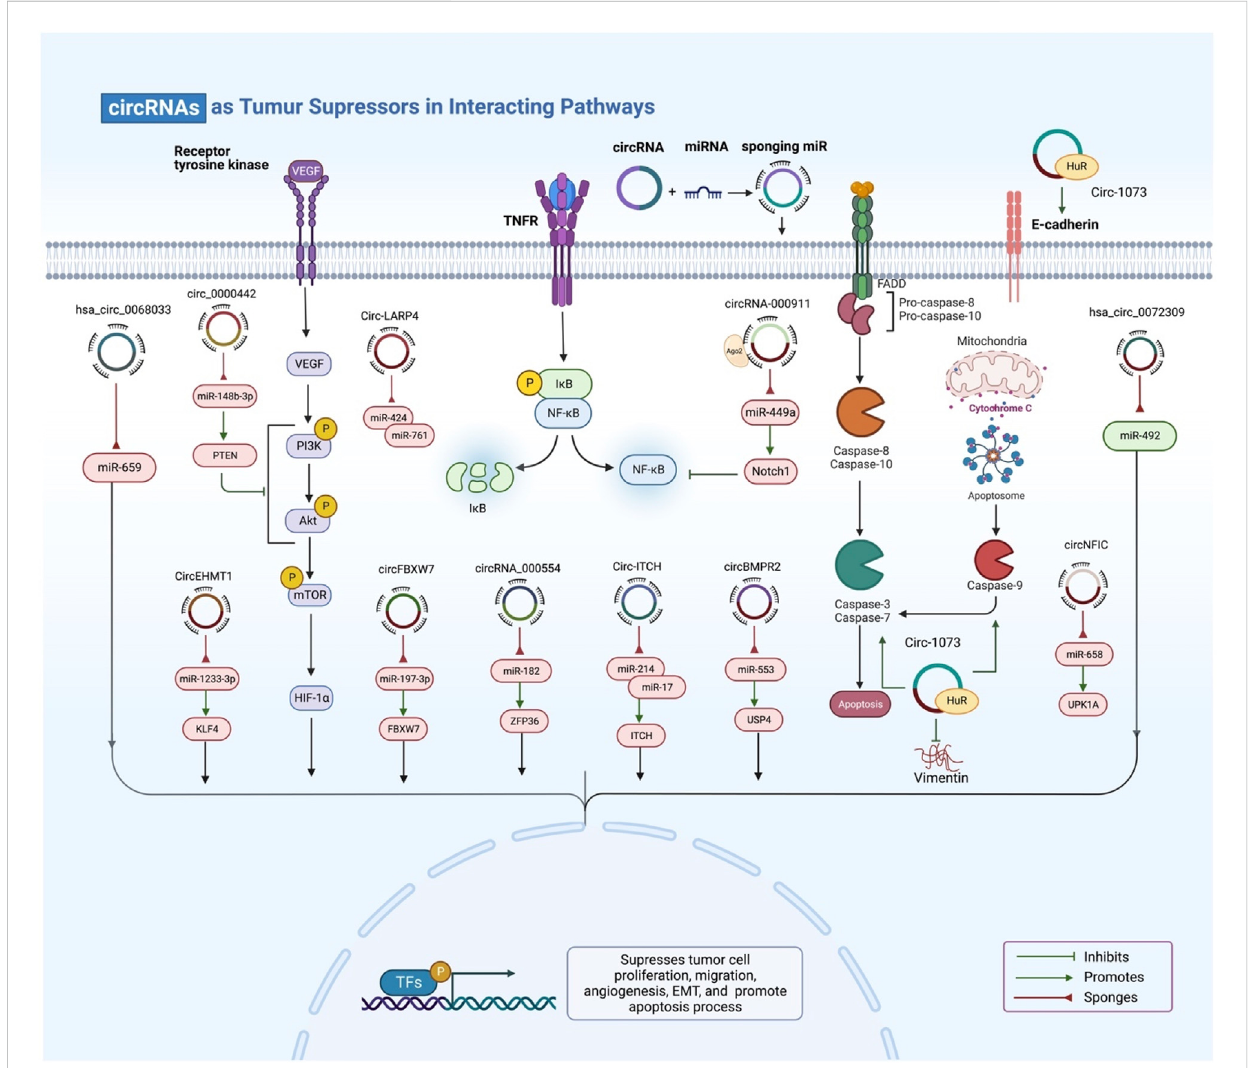
FIGURE 4 Exosomal circRNAsact as tumor suppressors. BytargetingmiRNA,genes, and avariety of signalling pathways,exosomalcircRNAscaninhibittumor cell proliferation, migration, angiogenesis, and EMT and stimulate